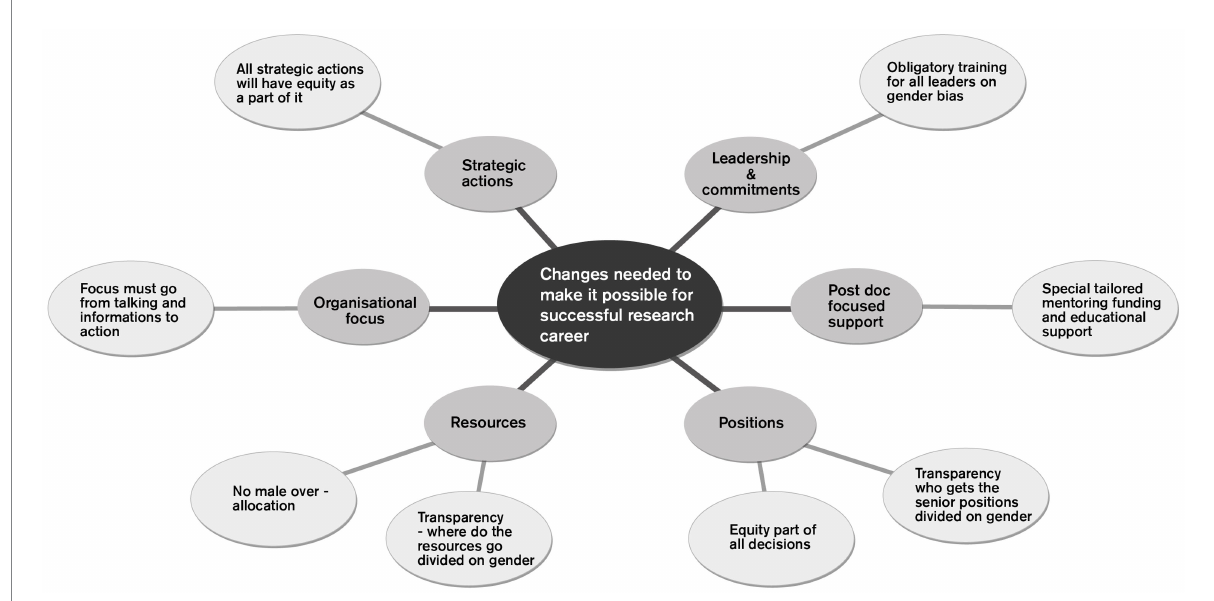
FIGURE 4 Sub-themes that emerged from the focus group discussions for changes needed for the WECRs to have a successful research